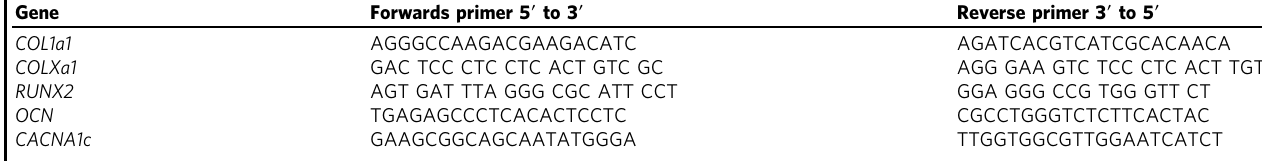
Table 1 List of primers used for